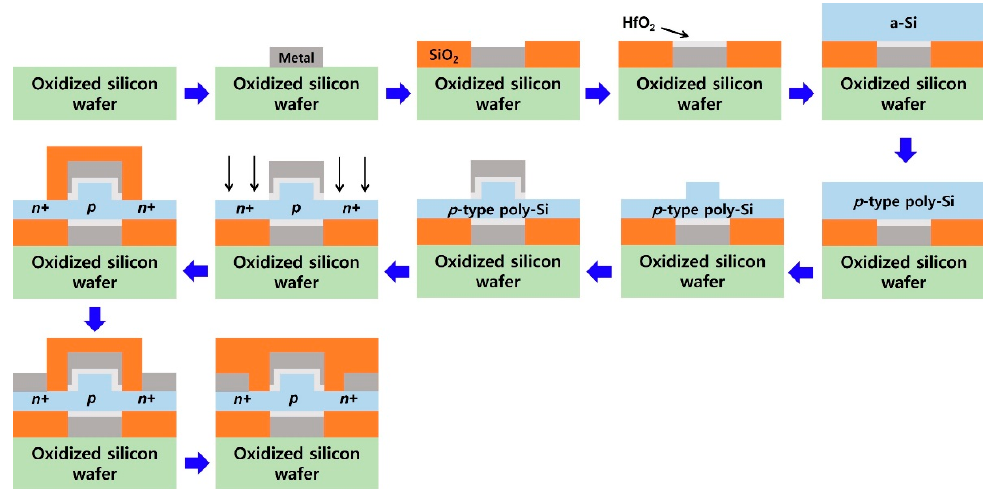
Figure 2. Key fabrication steps of proposed 1T-DRAM based on a poly-Si dual-gate MOSFET with a fin-shaped structure crystallized via excimer laser crystallization [23].